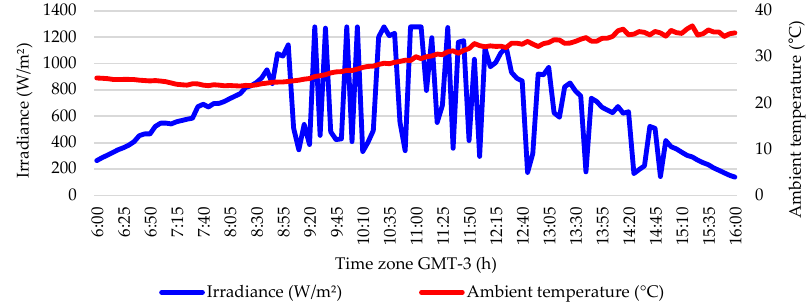
Figure 10. Forecasting condition.